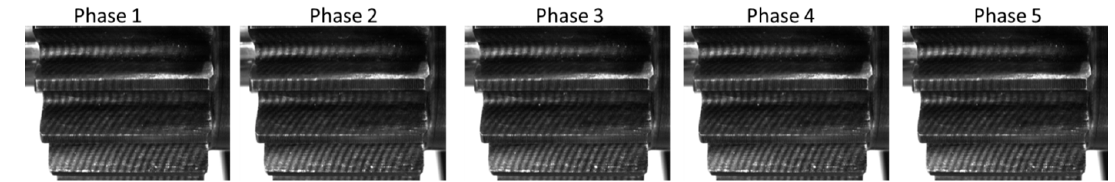
Figure 7. Moiré fringes on the gear tooth surface for each phase-shifting step.